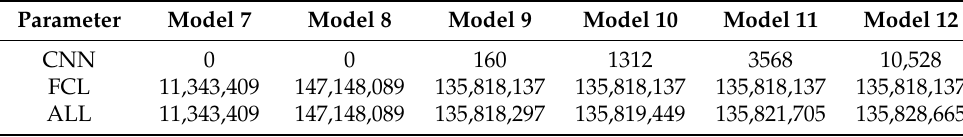
Table 7. Trainable parameters of Group